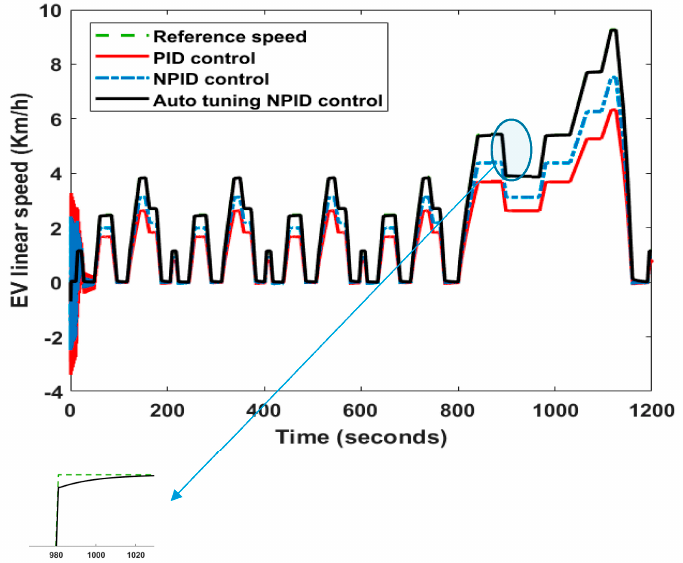
Figure 7. Performance of the PID, NPID, and auto-tuning NPID to track the NEDC speed test.